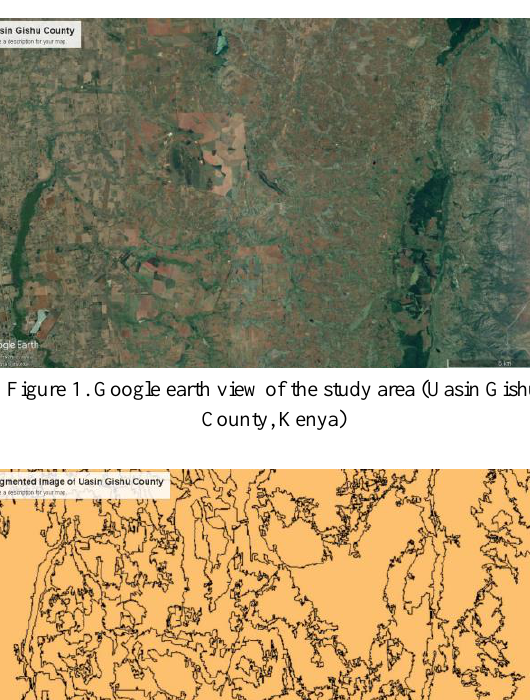
Table 1 details the statistics of image objects in the generated SMC map and Fig. 4 and 5 demonstrate the produced soil moisture map with the proposed approach.